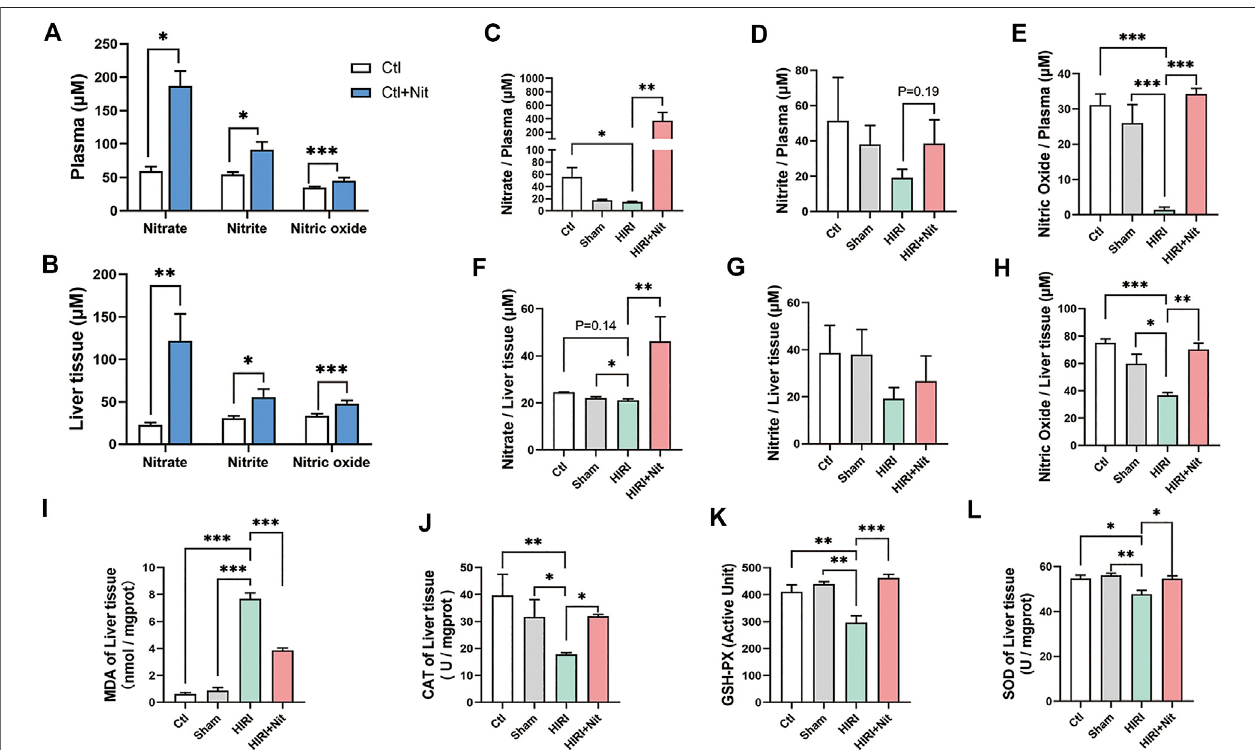
FIGURE 3 | Effectsof 4 mM dietary nitrate on levels of nitrate, nitrite, and NO as well asthe oxidative index in the liver tissue. (A) The nitrate, nitrite, and NOlevels of theplasmainCtlandCtl+Nitgroups. (B) Thenitrate,nitrite,andNOlevelsofthelivertissueinCtlandCtl+Nitgroups.Thelevelsof (C) nitrate, (D) nitrite,and (E) NOinthe plasmaofCtl,Sham,HIRI,andHIRI+Nitgroups.Thelevelsof (F) nitrate, (G) nitrite,and (H) NOinthelivertissueofCtl,Sham,HIRI,andHIRI+Nitgroups. (I) Thelevelsof MDA and the activities of (J) CAT, (K) GSH-PX, and (L) SOD in Ctl, Sham, HIRI, and HIRI + Nit groups. Data are expressed as mean ± SEM, *p ＜ 0.05, **p ＜ 0.01, ***p ＜ 0.001, and NS denotes no signi fi